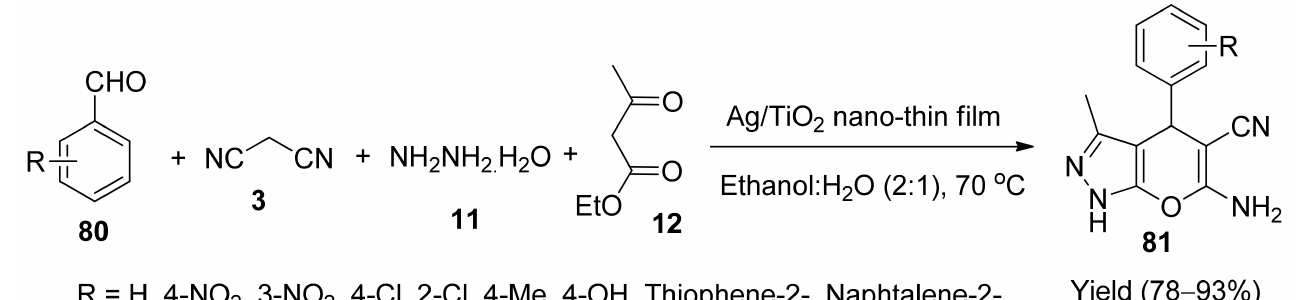
Scheme 22. Synthesis of pyranopyrazole derivatives 81 using Ag/TiO 2